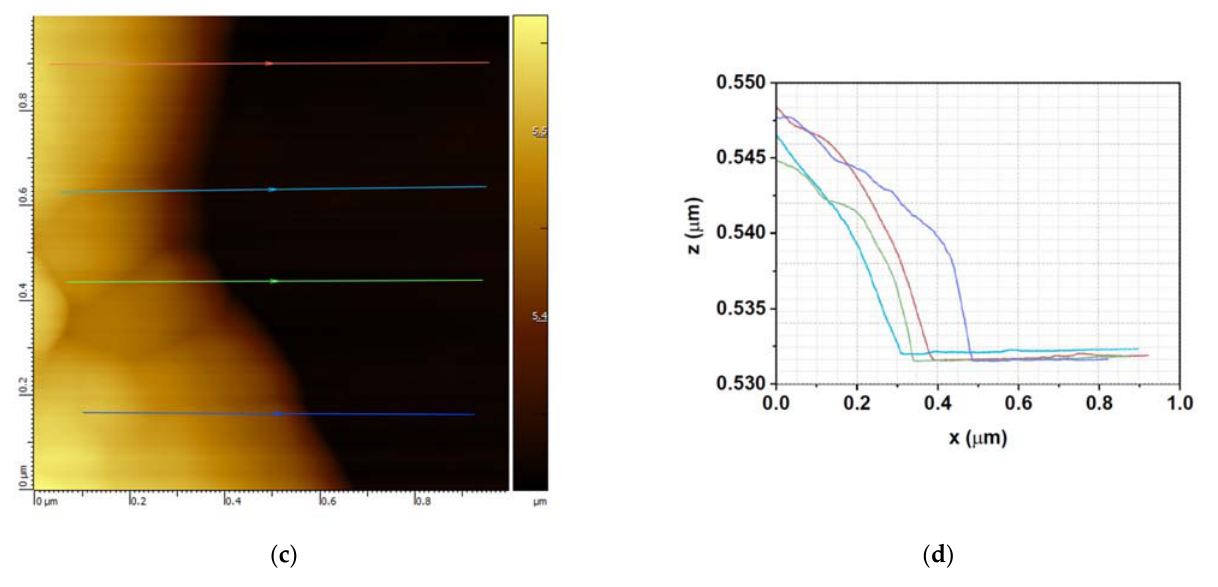
Figure 3. Microscopy images of an etched region of FLG on quartz: ( a ) SEM image; ( b ) 3D AFM image; ( c ) 2D AFM image; ( d ) AFM profiles of the etched quartz regions.